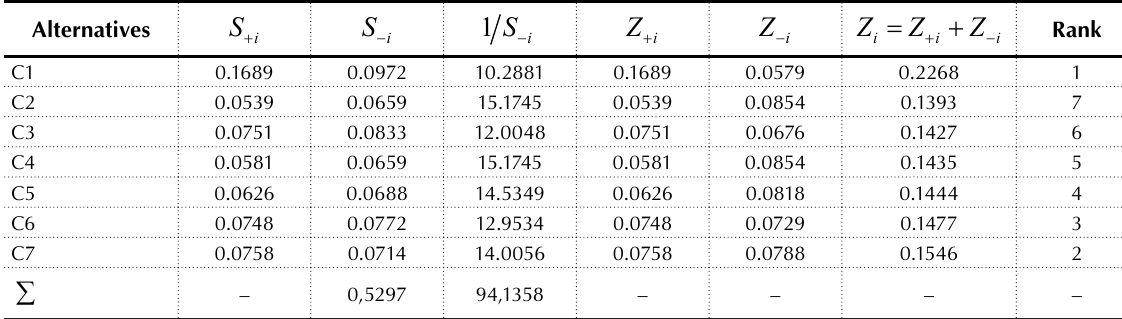
Source: Compiled by